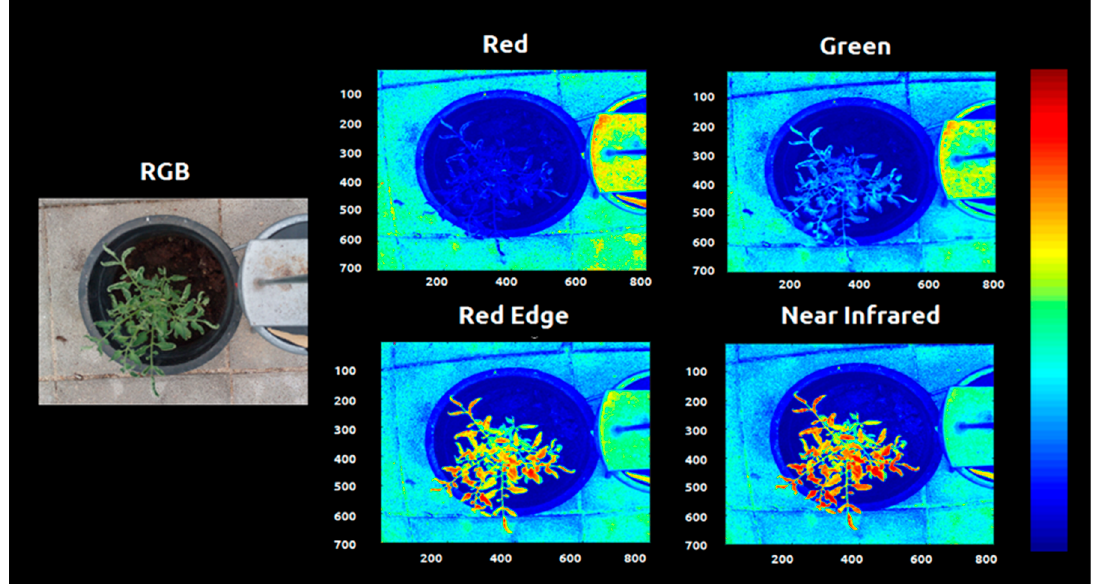
Figure 4. Types of images produced by the sensor after shifting and clipping the area of interest (700 × 800 resolution). (Bluish colors indicate regions with lower levels of reflectance and reddish colors indicates regions with higher levels of reflectance).